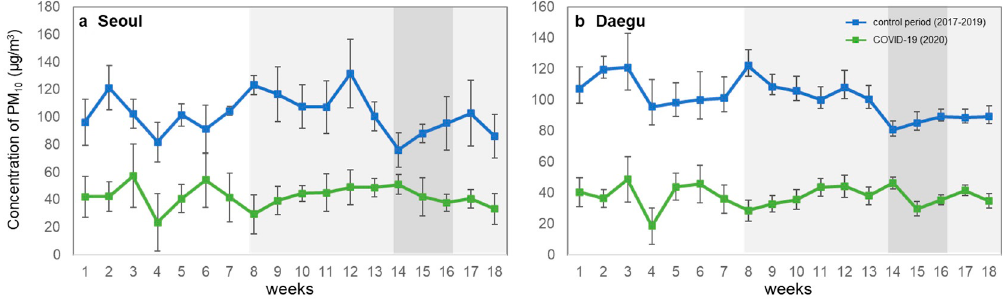
Figure 4. Comparison of average PM 10 concentrations by week between 2020 and the previous three years in ( a ) Seoul and ( b ) Daegu. Highlighted shadow represents the level of social distancing. The error bar means standard deviation.